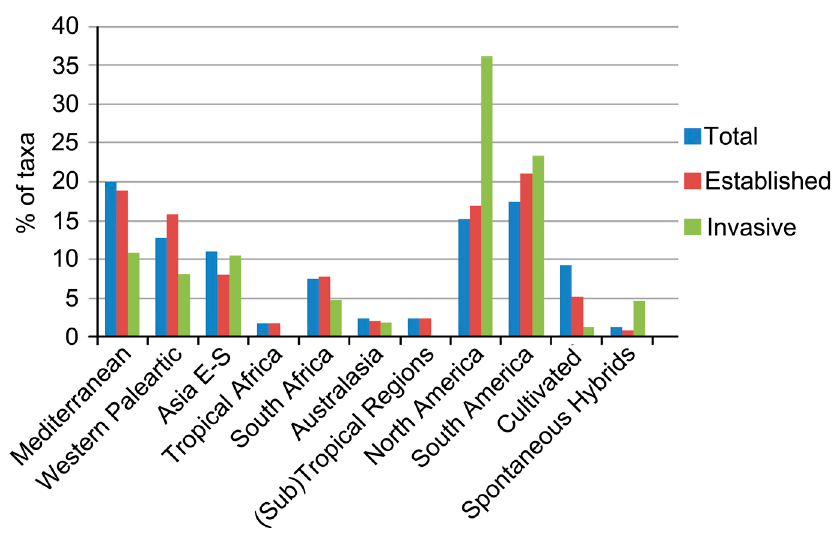
Figure 5. Proportional contribution of the world regions (and taxa originated through hybridization) to the alien flora of Catalonia.